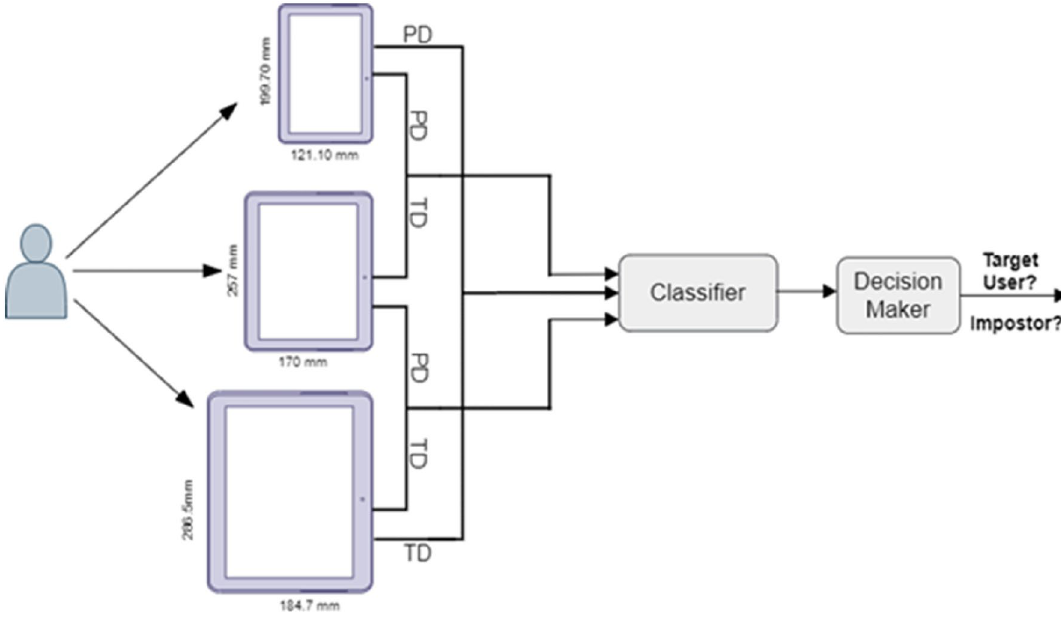
Figure 3. KDA system using different devices ( PD refers to profile data, while TD refers to test